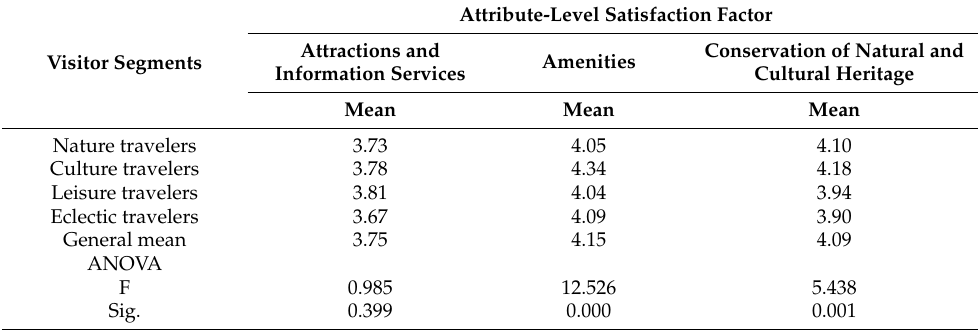
Table 5. The means of satisfaction factors divided by visitor segments according to travel